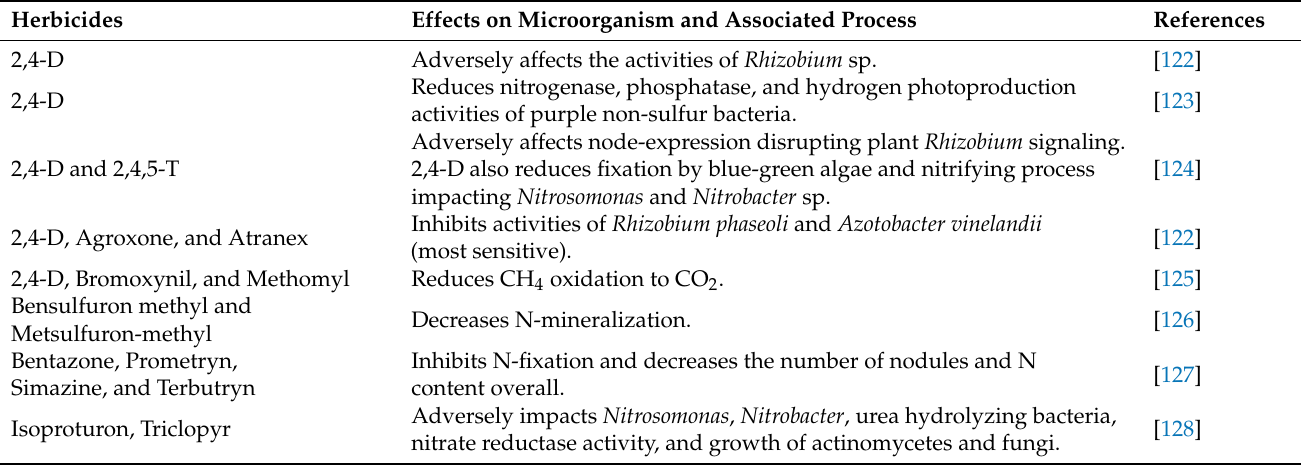
Table 1. Different herbicides with their reported effects on soil microorganisms and biochemical